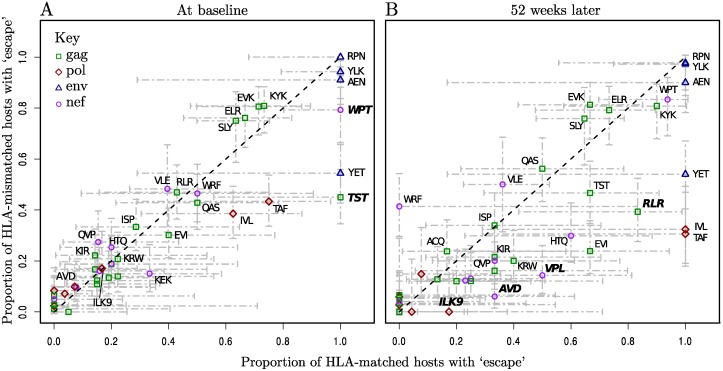
Escape prevalence in HLA-matched and-mismatched hosts.Epitopes are labelled where possible with their first three amino acids, and length if necessary to distinguish them. Bars represent 95% binomial confidence limits (Agresti-Coull method). The dotted black line is y = x. Epitopes labelled in bold have a significantly higher proportion of escape in matched hosts than in mismatched hosts (one-tailed Fisher’s Exact test, p < 0.1, note that multiple testing was not corrected for since the purpose of these tests was simply to give a relative measure of significance). Raw data for the number of patients in each category can be found in S3 and S4 Tables. First visit (baseline) sequence data was available in at least one gene for 122/125 patients. The range of time from seroconversion among these patients was 1–20 weeks, median 11. (A) At baseline the majority of epitopes have escape at equal prevalence in HLA-matched and-mismatched hosts (B) 52 weeks later within-host evolution has resulted in a higher prevalence of escape in HLA-matched hosts for many epitopes, and in the distribution as a whole HLA-matching and escape are now significantly associated (p < 0.01, permutation test, see Methods for details).